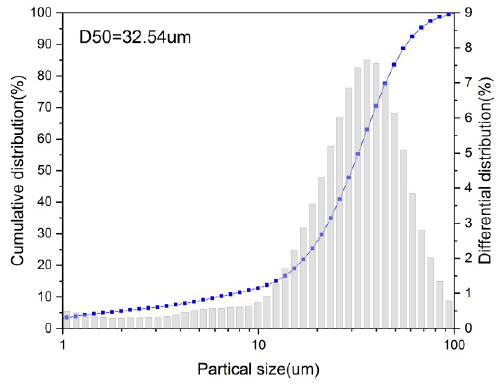
Figure 3. Particle size distribution curves of FGD gypsum.